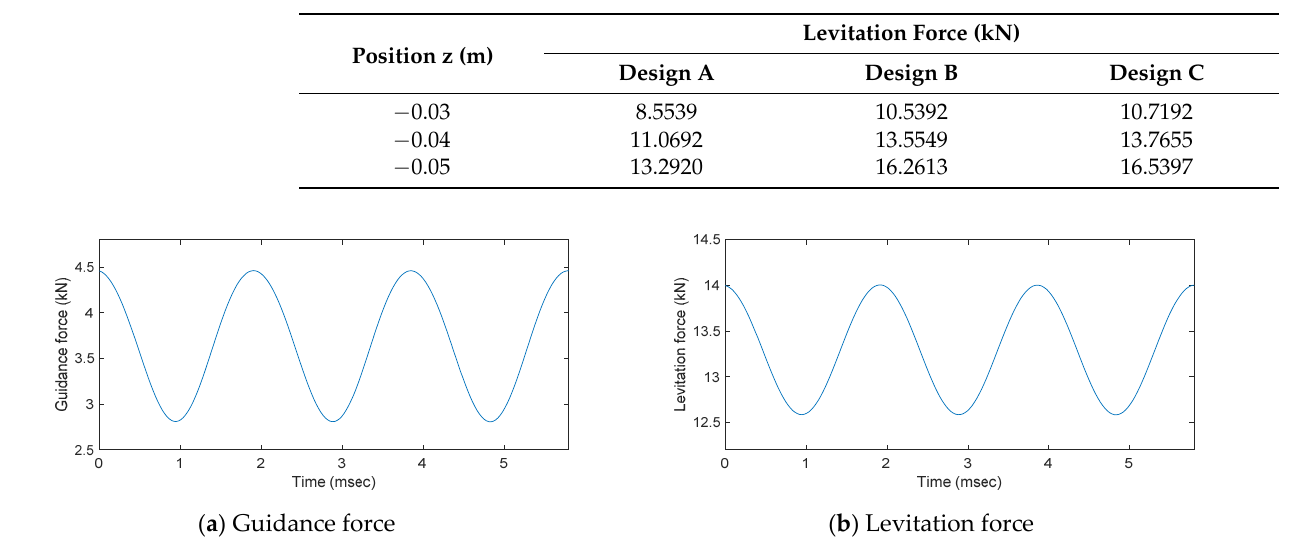
Figure 5. Levitation/guidance force in the time domain (Design A).